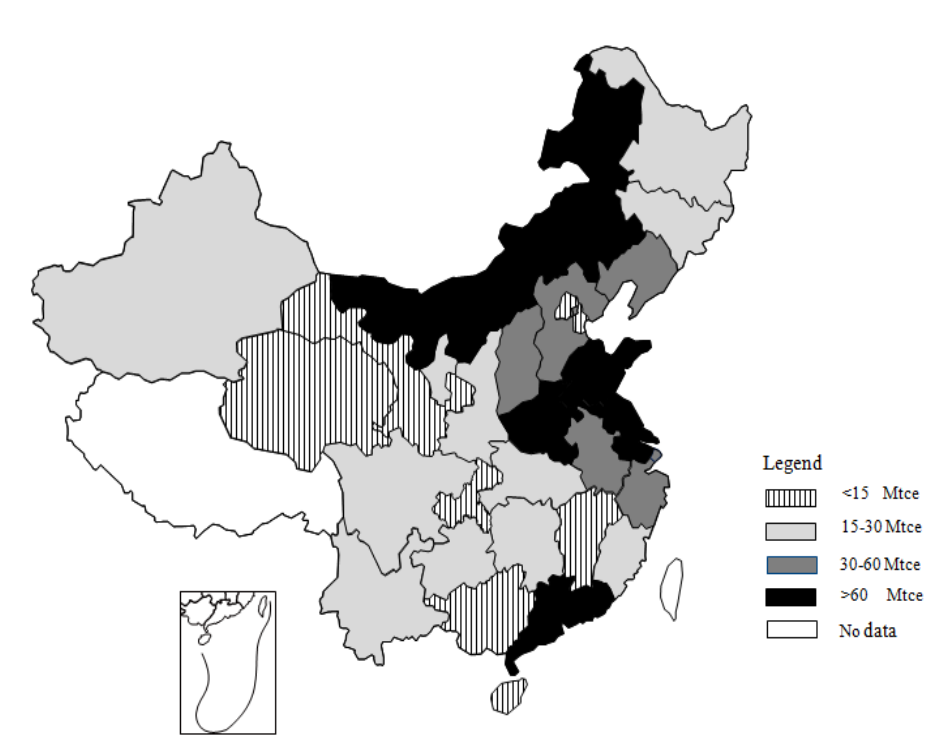
Figure 5. The distribution of 30 provinces based on the energy consumption for thermal electricity generation.